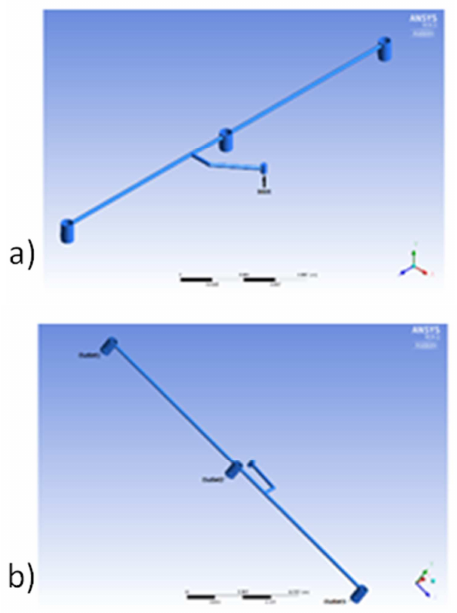
Fig. 5. An arrangement of the gasket relative to the head, a) correct, b) incorrect, c) enlarging the view of the pocket before entering the oil main line for camshaft